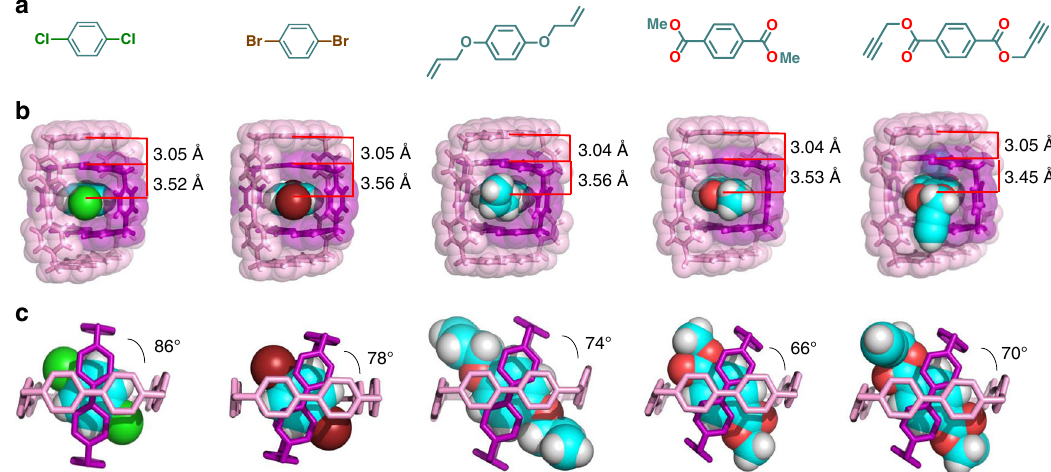
Fig. 8 Solid-state superstructure of Russian doll assemblies with different guests inside the [ CBPQT ⊂ 1 ] 4( + (cid:129) ) complex. a Structural formulas of the guest molecules. b Perspective views depicted as tubular and space- fi lling representations. c Side-on views depicted as tubular representations. Hydrogen atoms are omitted for the sake of